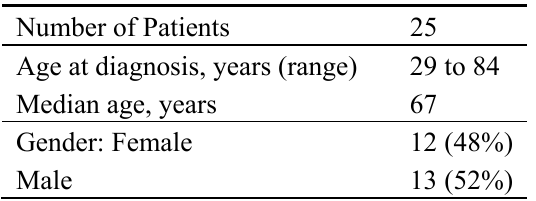
Table 3. Patient